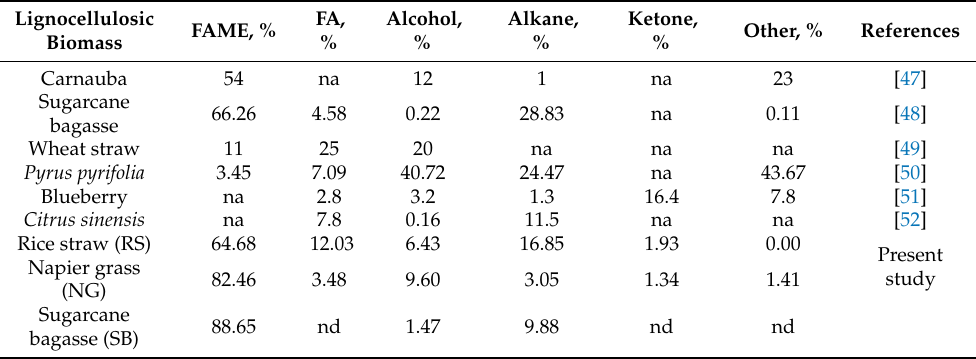
Figure 7. Chemical groups identified by GC-MS analysis of wax extracted from different biomass types using hexane. FAME—fatty acid methyl ester; FA—fatty acid; RS—rice straw; NG—Napier grass; SB—sugarcane bagasse. Table 2. Studies related to compositional analysis of wax extracted from different lignocellulosic biomass types.